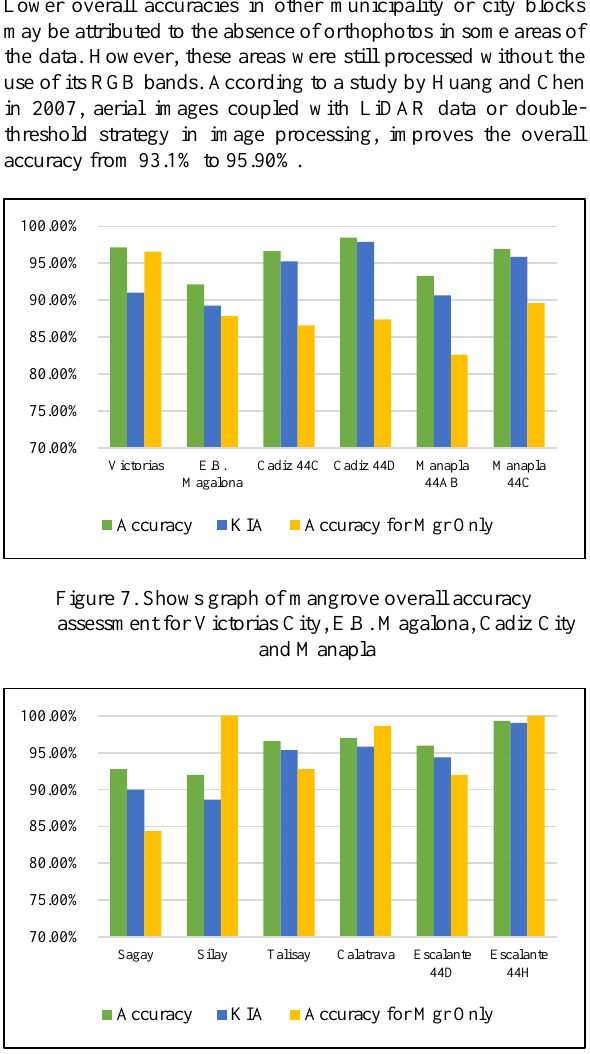
Figure 8. Shows graph of mangrove overall accuracy